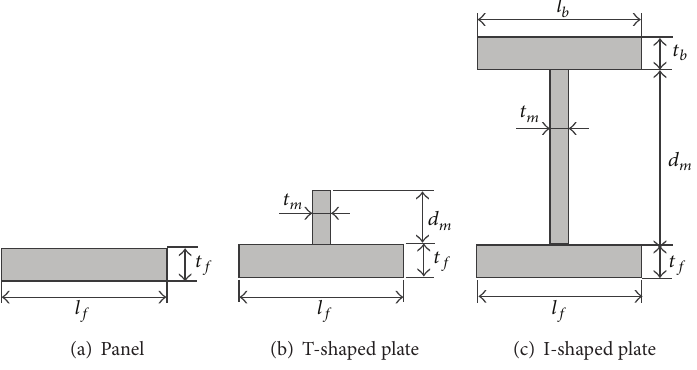
Figure 2: The geometries of the three substructures used in this analysis.